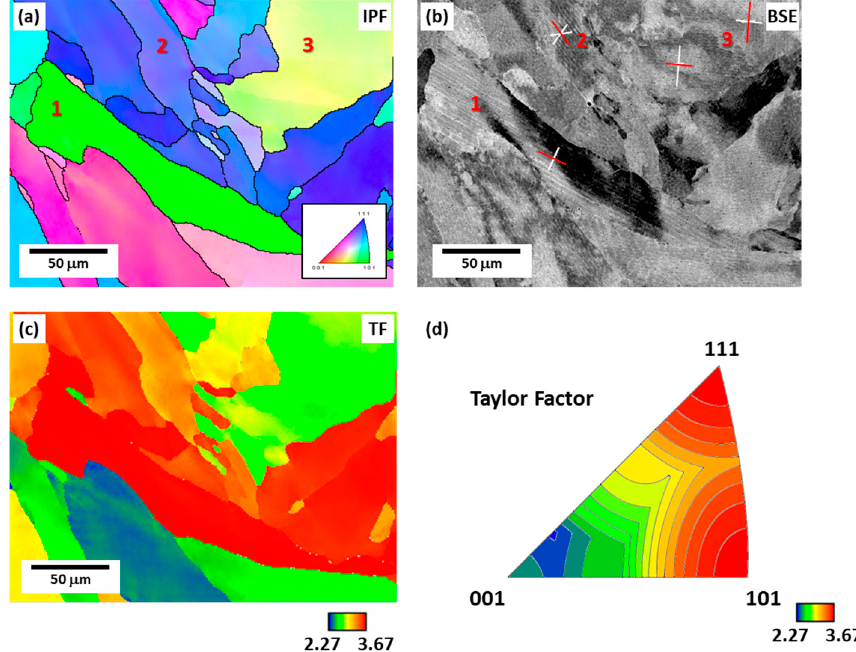
Figure 4. Microstructures of the TD plane: ( a ) EBSD inverse pole figure (IPF) map, ( b ) backscattered electron (BSE) image, ( c ) Taylor factor (TF) map, and ( d ) TF distribution according to grain orientation. Grain 1, denoted by the number 1, is composed of the lath-like cellular structure; grain 2 consists of both elongated type; and both elongated and lath-like cellular type are observed in grain 3. Table 1. Type classification according to grain orientation and cell growth